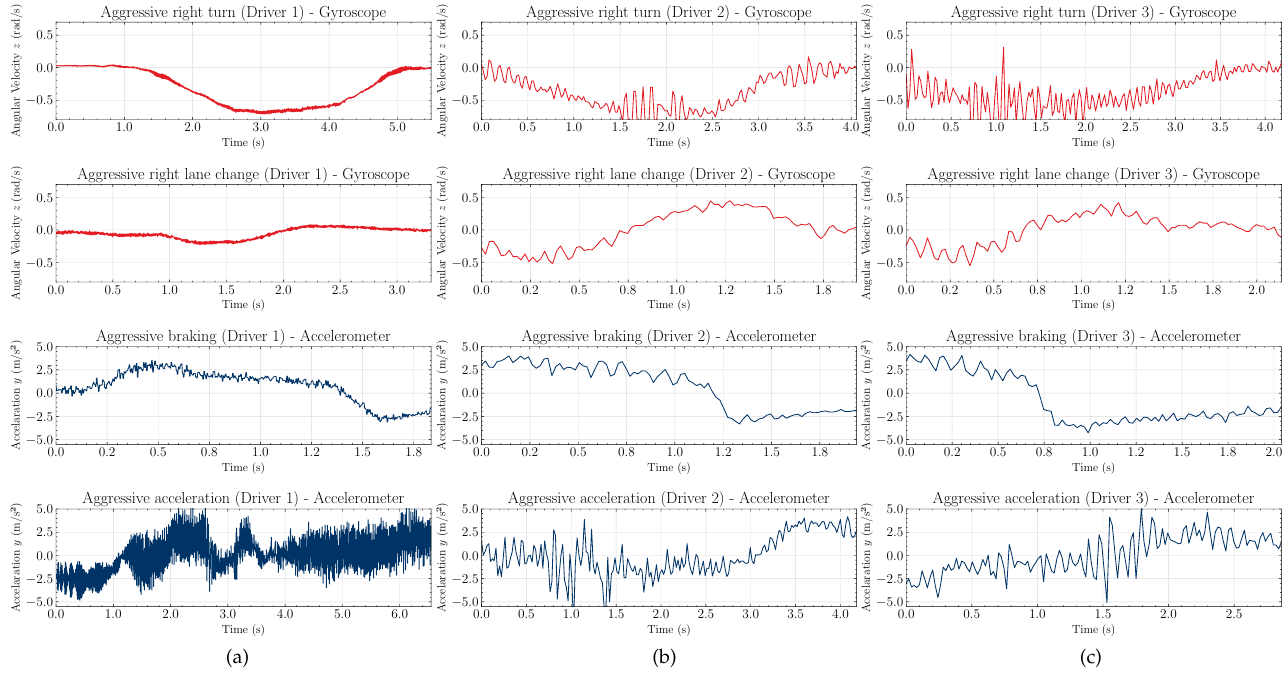
Figure 6. Examples of driving events performed by three different drivers: ( a ) first, ( b ) second, and ( c ) third driver. The angular velocity in z (first and second rows) for aggressive right turn and aggressive right lane change, and linear acceleration data in the y (third and fourth rows) for aggressive braking and aggressive